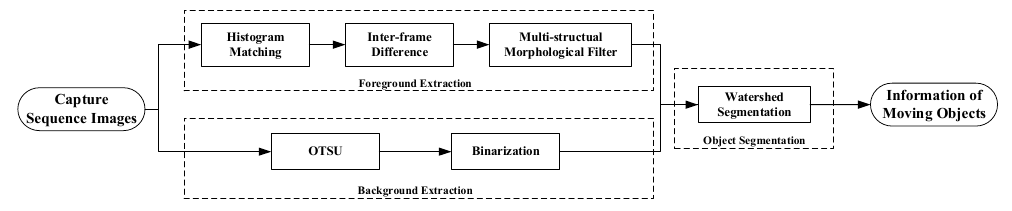
Figure 2. The algorithm flow.